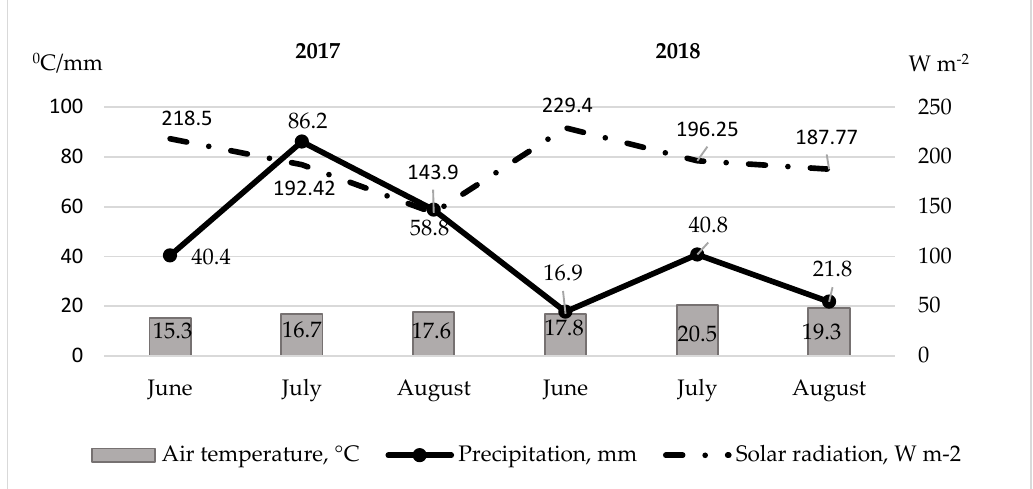
Figure 4. Meteorological conditions.